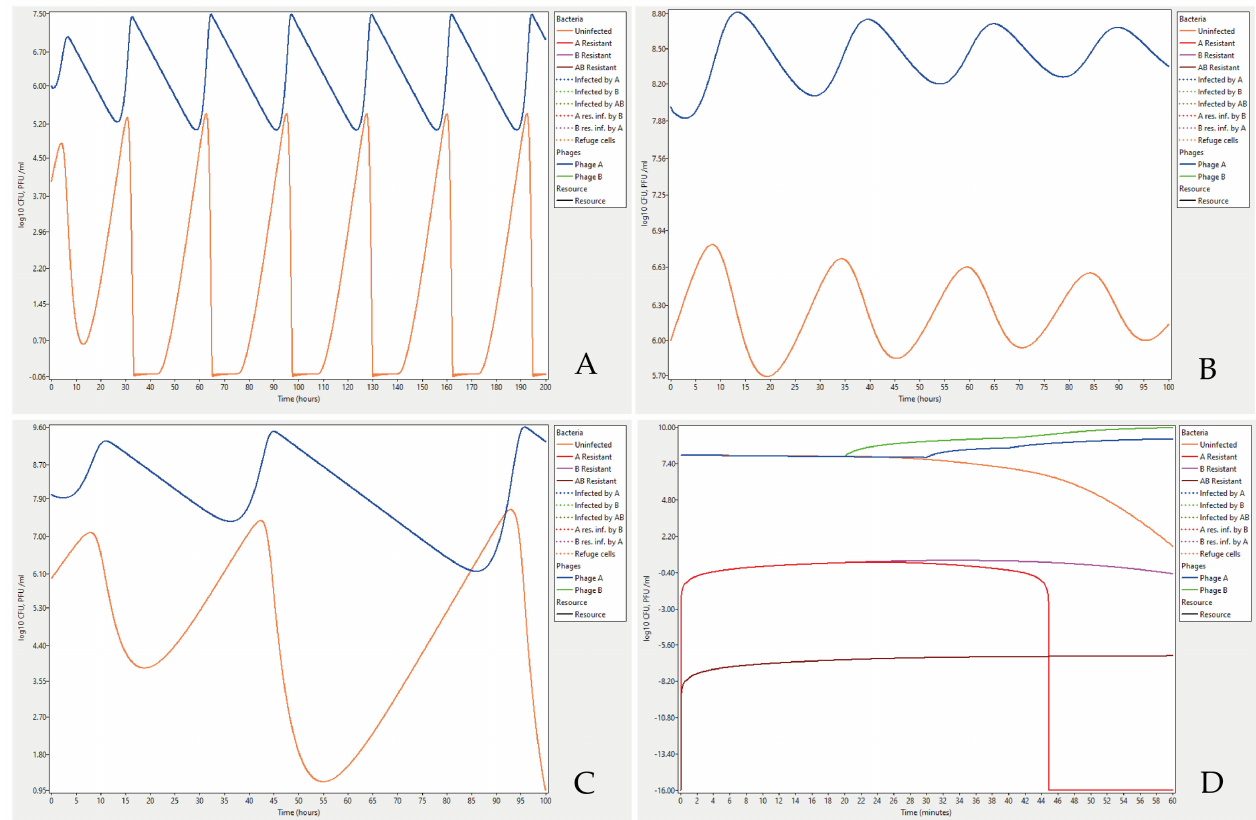
Figure 2. Example output graphs from the Cocktail program: ( A ) Escherichia coli bacteria infected with phage T4 in a chemostat where both the bacteria and the phage titre fluctuate under certain conditions. The parameter settings were as in [26] with the exception of the resource density being set to 1.0 instead of 0.5 mg/L ( µ g/mL) in the chemostat, and the time step size set to 1 min instead of 3 min. The run was for the first 200 h of the original chemostat experiment (before development of bacterial phage resistance). Complete parameter settings can be found in the file Bohannan_Lenski_1997_ Fig 3B.ctl in the Supplementary Materials. ( B ) Oscillations of bacterial and phage can theoretically exist even at higher titres as shown by Lenski [19]. Bacteria in a titre of 10 6 cell forming units is infected with virulent phages with a burst size of 100 and in a titre of 10 8 . The stability of the system depends on a low concentration of nutrients, 25 µ g/mL. The parameter settings can be found in the Supplementary Materials file Lenski_1988_Fig_2a.ctl. ( C ) As the concentration of nutrients increases four times, the titres of both bacteria and phages shift. This results in increasingly large oscillations where bacterial titres are reduced to a few cells every cycle, but they never become extinct. The settings are from the file Lenski_1988_Fig_2b.ctl. in the Supplementary Materials. ( D ) An example of bacteria at high titres simultaneously infected by two phages with different infection characteristics. Bacteria that mutate and become resistant to either one of the phages are eventually lost and non- resistant bacteria slowly become extinct but replaced by bacteria resistant to both phages. See text for more details. Settings from the file Fig_2D.ctl in the Supplementary